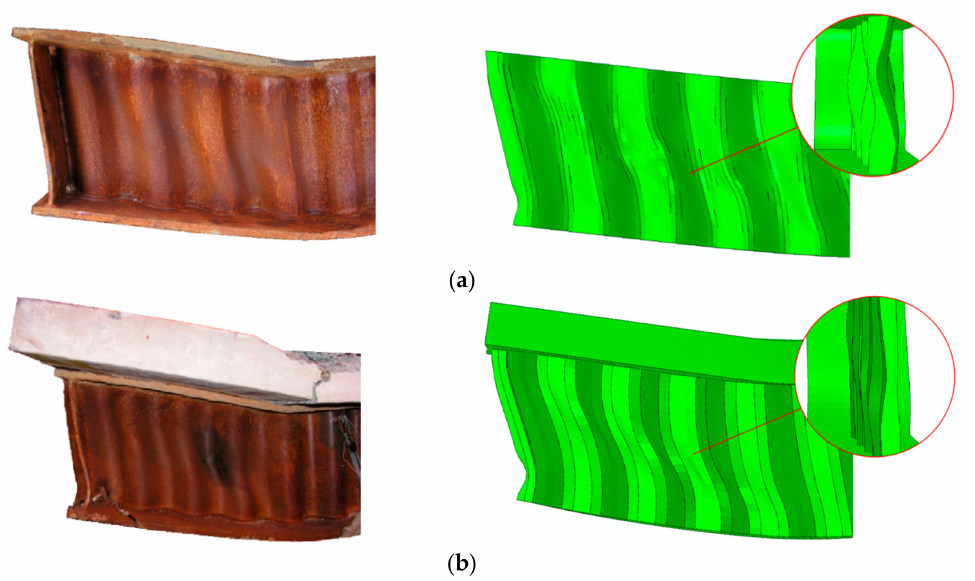
Figure 11. Comparison of failure modes caused by global buckling of the web determined through experimental tests and numerical analysis: ( a ) steel beam; ( b ) beam bonded to a reinforced concrete